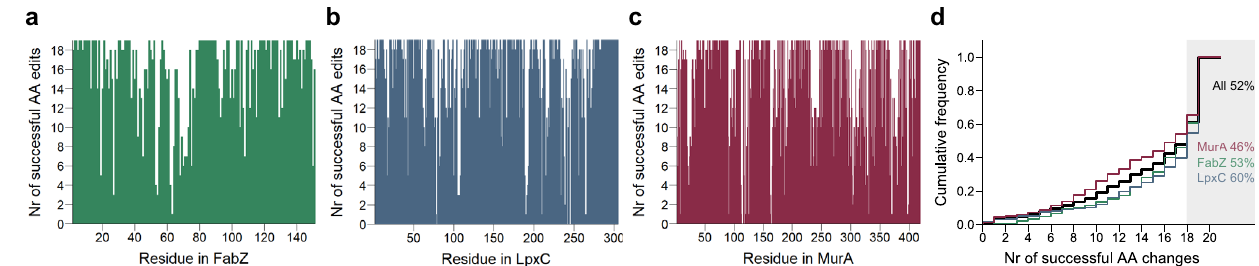
substitutionsdetectedafter15generationsofgrowthisshownforalllibrariestaken together (All) or the FabZ, LpxC and MurA library separately. The percentage of residues that tolerates all or all but one amino acid changes ( ≥ 18) is stated and highlighted at the right side of the fi gure. Source data are provided as Supple- mentary Data 3. AA amino